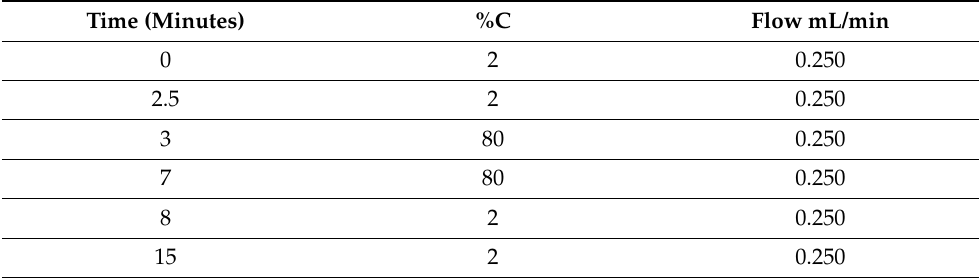
Table 1. Chromatographic